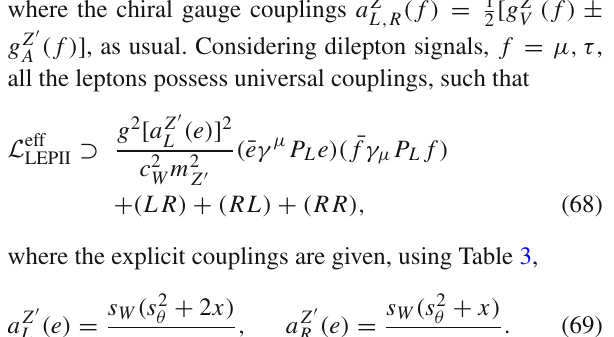
Fig. 3 Dileptonproductioncross-sectionasfunctionof Z (cid:7) mass,where dotted lines denote observed limit for different widths extracted at dilepton invariant-mass resonance, using 36.1 fb − 1 of pp collision at √ s = 13 TeV by ATLAS [28]. The black and gray dotted lines are theoretical prediction according to x = 1 / 2 and − 1 / 2,